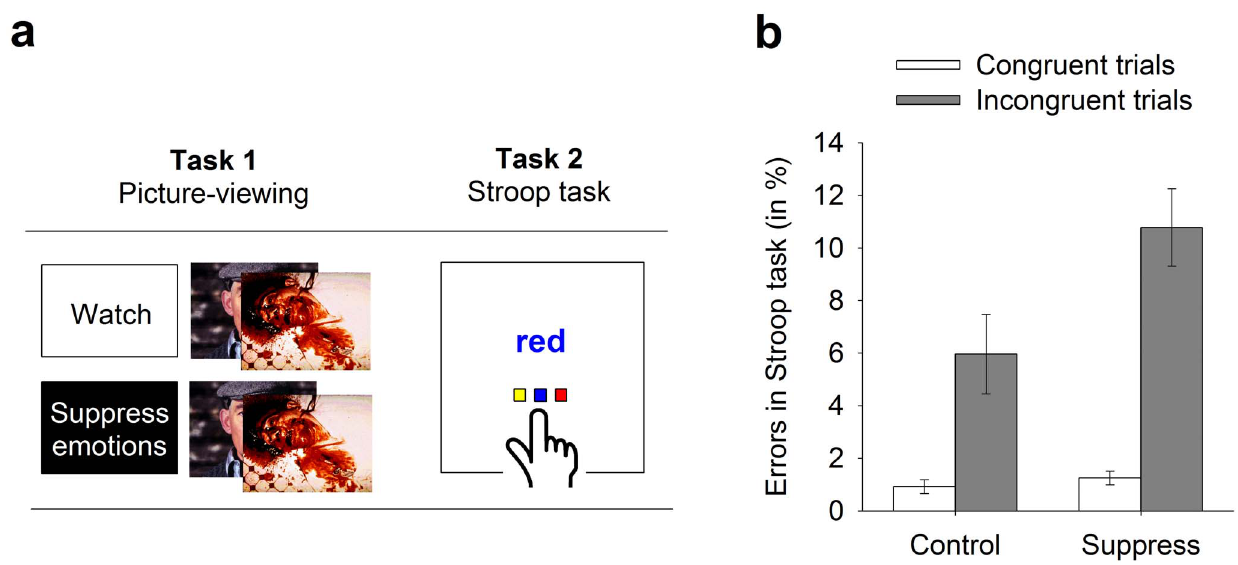
Figure 1. Overview of the experimental procedure and the behavioral results. (a) During the first task, the control group watched negative and neutral pictures. The suppression group suppressed emotions while watching the same pictures. Both groups subsequently completed a Stroop task. Brain imaging data was recorded during both tasks. (b) Participants in the emotion suppression group showed significantly stronger Stroop interference effects than participants in the control group. (Errors on incongruent minus errors on congruent trials.) Error bars represent standard errors of the mean (SE).